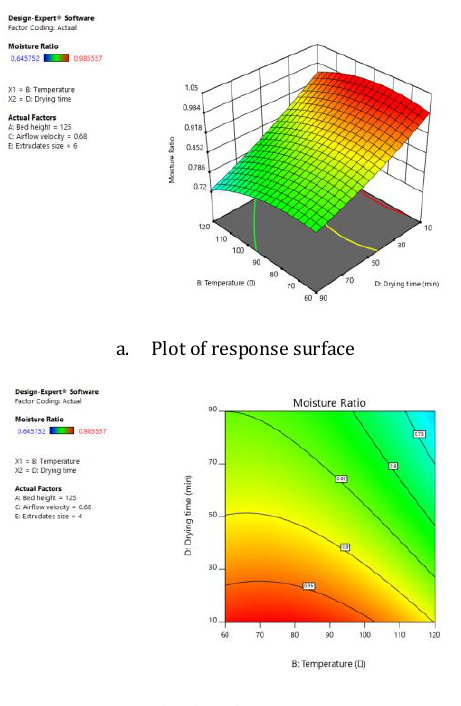
Figure 3: 3-D representation of the interaction between temperatue and drying time at 4mm extrudates size on moisture ratio.